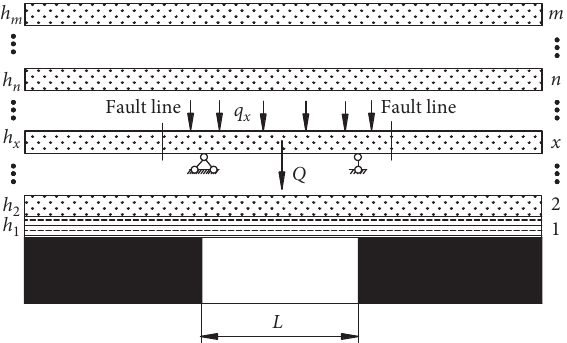
Figure 5: Mechanical model of the lintel structure of the layered roof stratum of the roadway.